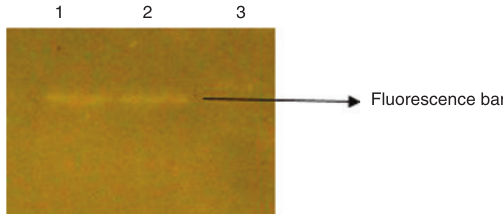
Figure 3: Activity staining of purified pterin deaminase: lane 1, FPLC purified fraction; lane 2, FPLC purified fraction; lane 3, ethanol precipitate.